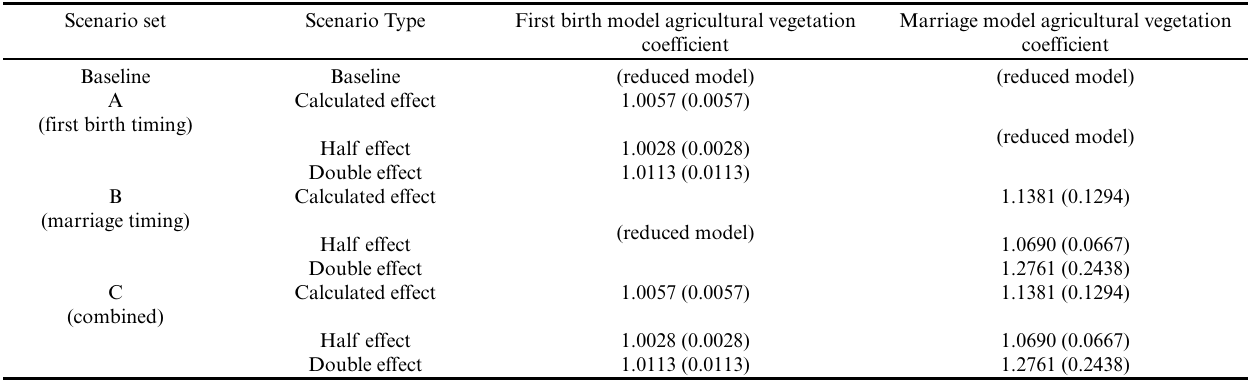
Table 5 . Parameter values for the three sets of scenarios. For columns 3 and 4, the first number listed in each cell is an odds ratio, and the number in parentheses is the equivalent coefficient value. The scenario set letters (A-C) are referred to in text and in later